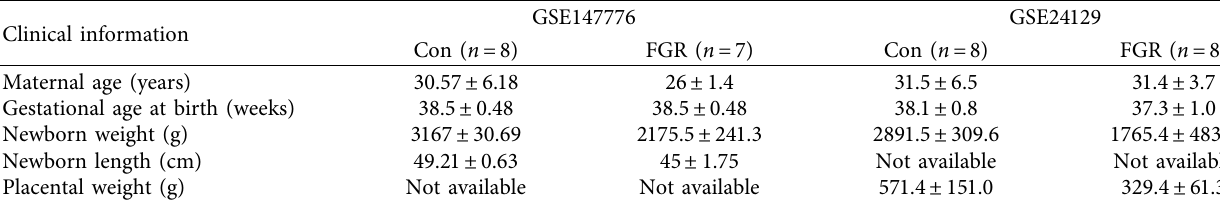
Table 2: Clinical information of GSE147776 and GSE24129.